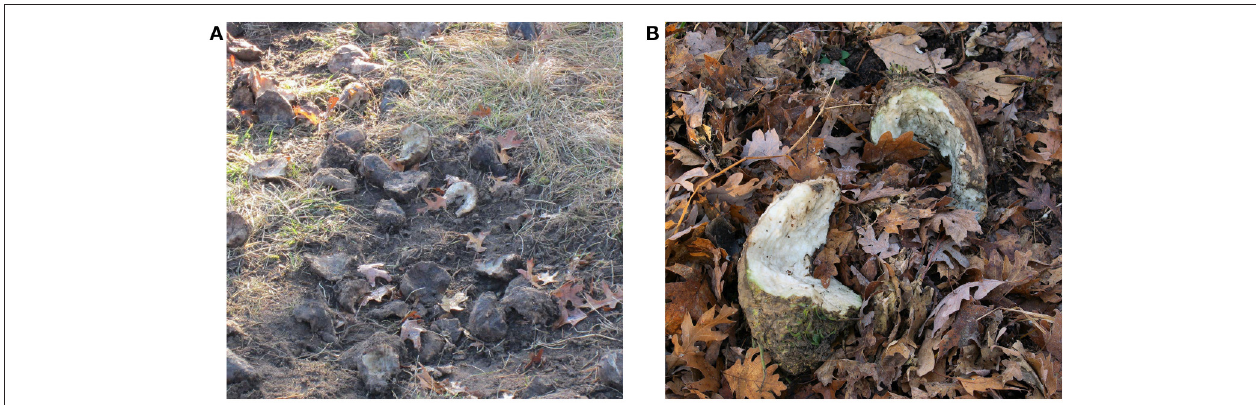
FIGURE 4 | Sugar beets ( Beta vulgaris subsp. vulgaris convar. vulgaris var. altissima ) in an illegal deer baiting site, Alcona County, Michigan. (A) Hoof traffic exposes soil which may act as a source of indirect exposure to M. bovis when contaminated by infected deer. (B) Teeth marks on sugar beets partially eaten by deer. M. bovis likely survives for extended periods on these foodstuffs under the cold, wet conditions typical of autumn and winter in northeastern Michigan.